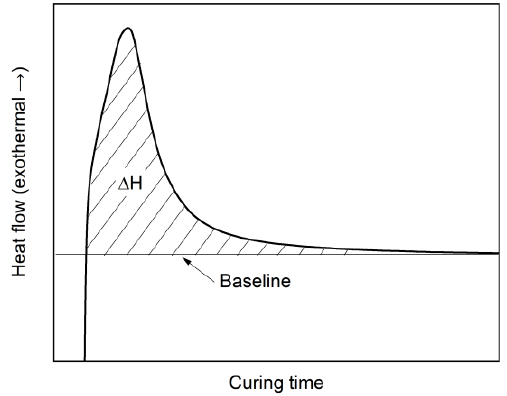
Figure 4. Determination of ∆ H iso in a schematical isothermal di ff erential scanning calorimetry (DSC) curing